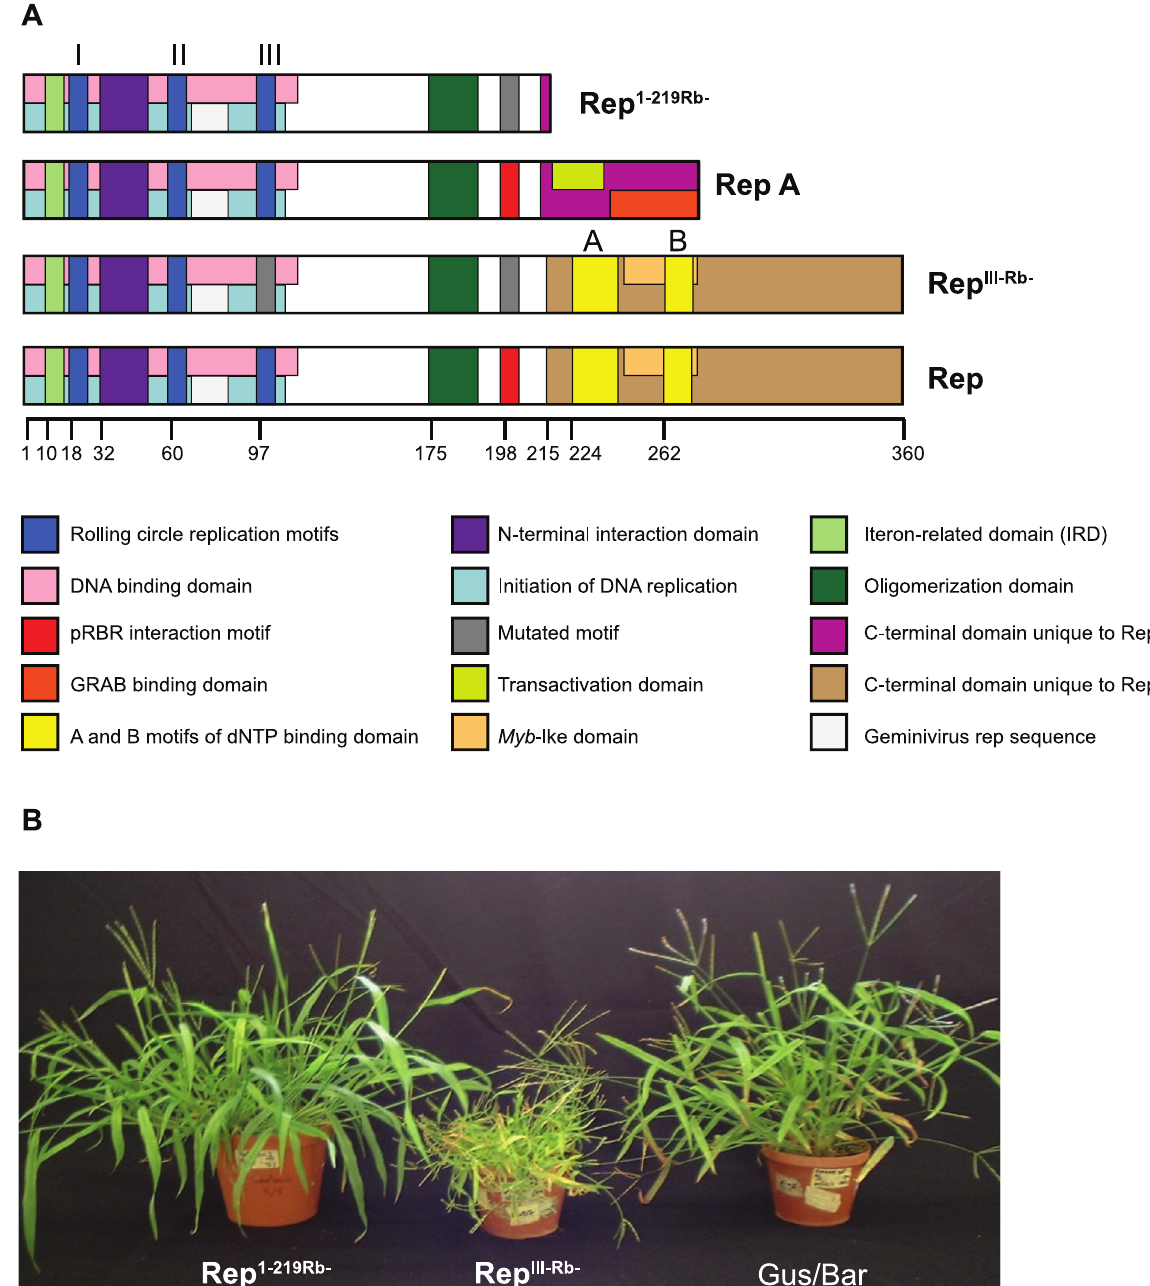
Figure 1. Products of mutated and truncated MSV rep genes used in the split gene cassettes, compared with the wild type. A) Known sequence motifs and functional domains present in each gene product are highlighted. Amino acid numbering is relative to the N-terminal methionine. Adapted from Shepherd et al. [17]. B) Three representative Digitaria sanguinalis lines constitutively expressing p rep 1–219Rb- (left), p rep III-Rb- (middle) or Gus and Bar (from pAHC25 [39]; right), illustrate the phenotypic effects of the transgenes. Photo from Shepherd et al. [17]. doi:10.1371/journal.pone.0105932.g001 Kit according to the instruction manual protocol: (http://search. cosmobio.co.jp